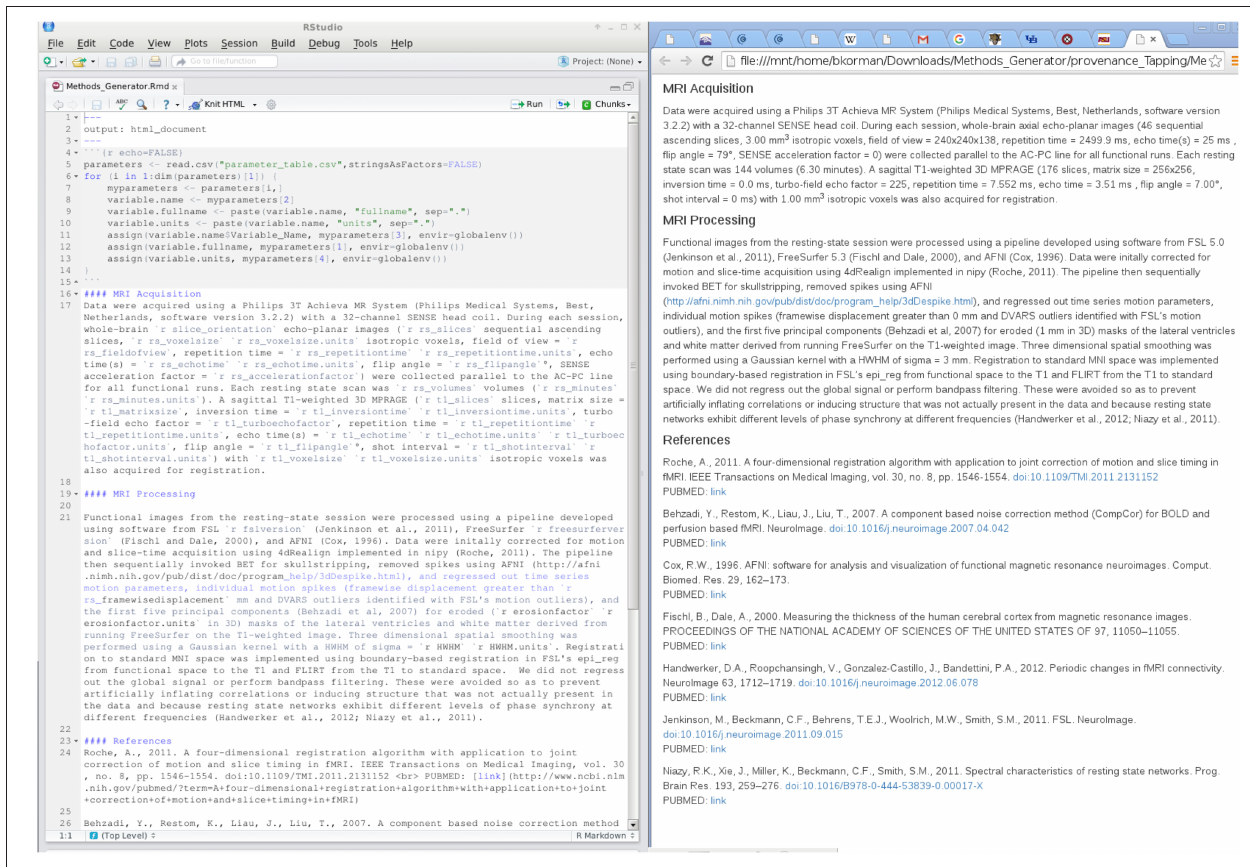
FIGURE 4 | Data provenance of resting state processing with R